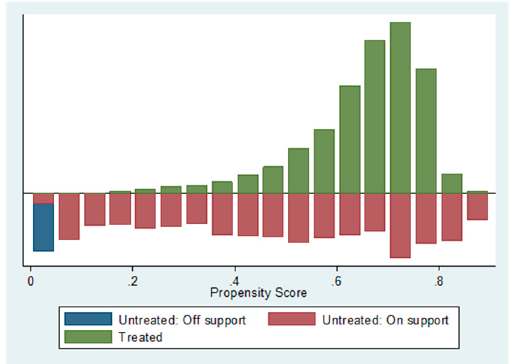
Figure 1. The PSM validity test 2: PM10.